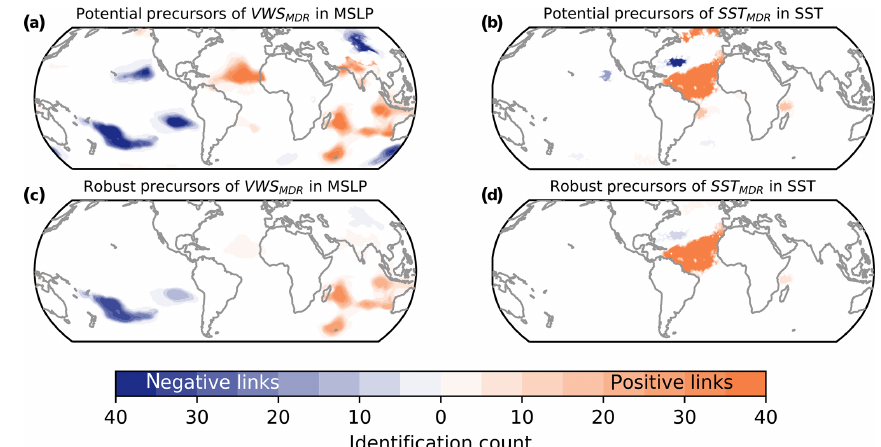
Figure 7. Potential and robust precursors of VWS MDR and SST MDR in March. As Fig. 4 but in March and with MSLP precursors for VWS MDR .